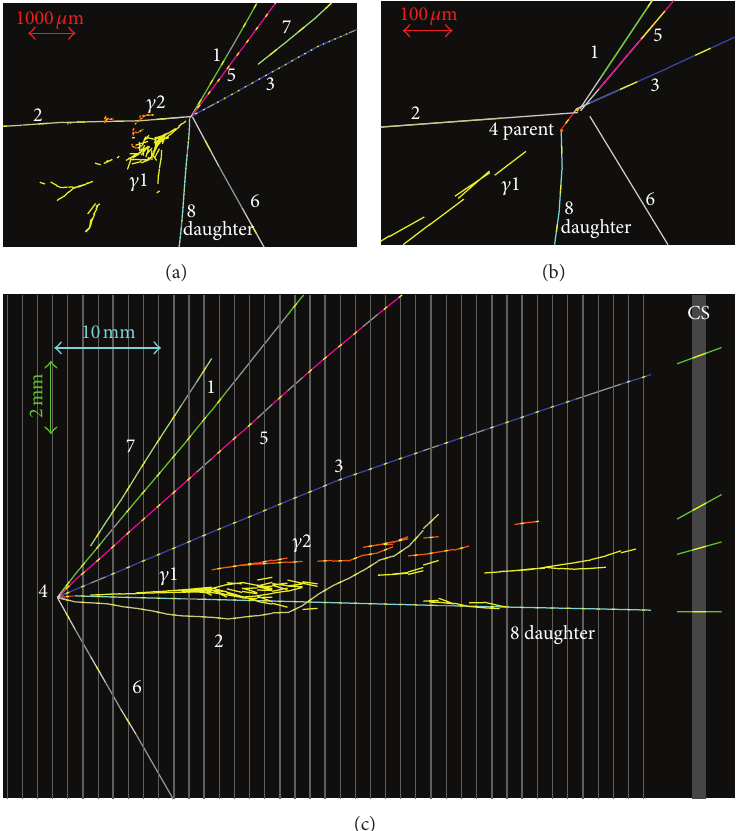
Figure 17: The first candidate 𝜈 𝜏 event observed by the OPERA experiment. (a) and (b) show the transverse view with the right plot being a zoom of the left. (c) shows the longitudinal view. The short red track (labeled as “4 parent”) is identified as being due to the 𝜏 lepton and the track of what is thought to be the tau-daughter is shown in turquoise (labeled as “8 daughter”). A kink is clearly seen, particularly in the zoomed transverse view (b), and demarked by the change in color from red to turquoise along the track. A detailed description of the likely candidates for each of the numbered tracks is given in the OPERA paper